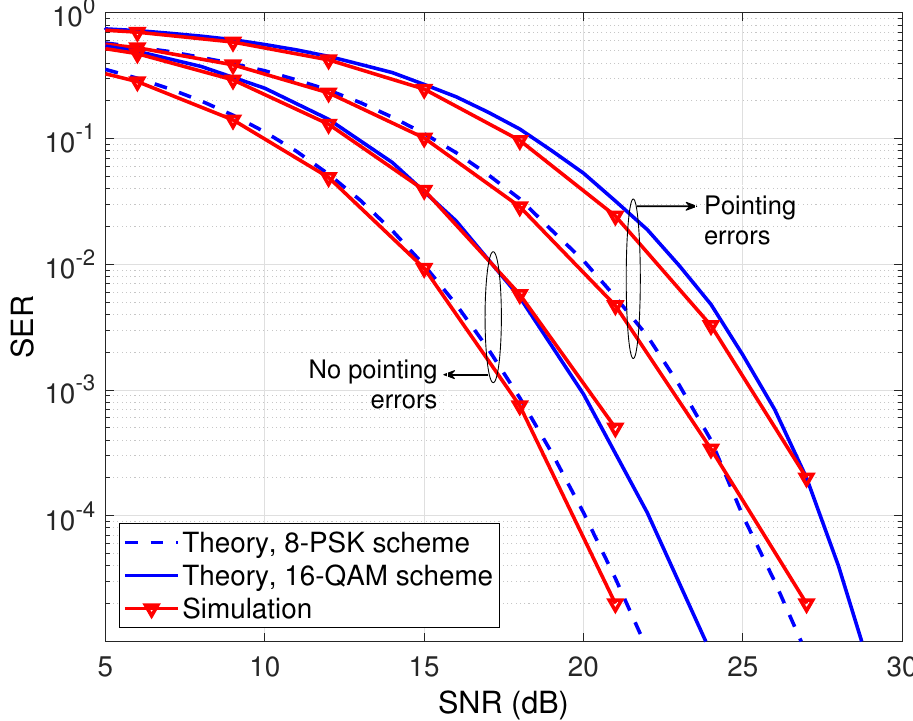
Figure 8. SER versus SNR for different modulation schemes with/without pointing